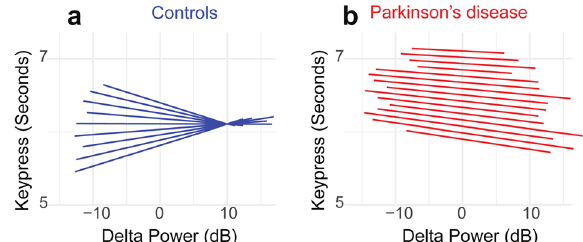
Fig. 3 Increased cue-triggered delta activity predicts decreased temporal variability in controls but not in Parkinson ’ s disease (PD). We plotted the slopes for each individual from our trial-by-trial linear mixed-effects model trial-by-trial delta power on keypress. This analysis revealed that for a controls, increased midfrontal delta power was associated with keypress that was more clustered around ~7 s; individual slopes plotted as blue lines. However, for b PD patients, there was no clear relationship between delta power and keypress; individual slopes plotted as red lines. These data indicate that for controls, increased delta power was linked with less timing variability, while PD patients (who had lower delta power overall, see Fig. 2b) had higher timing variability and less of an in fl uence between delta power and performance. Data from all trials in control ( n = 37) and PD ( n = 71)